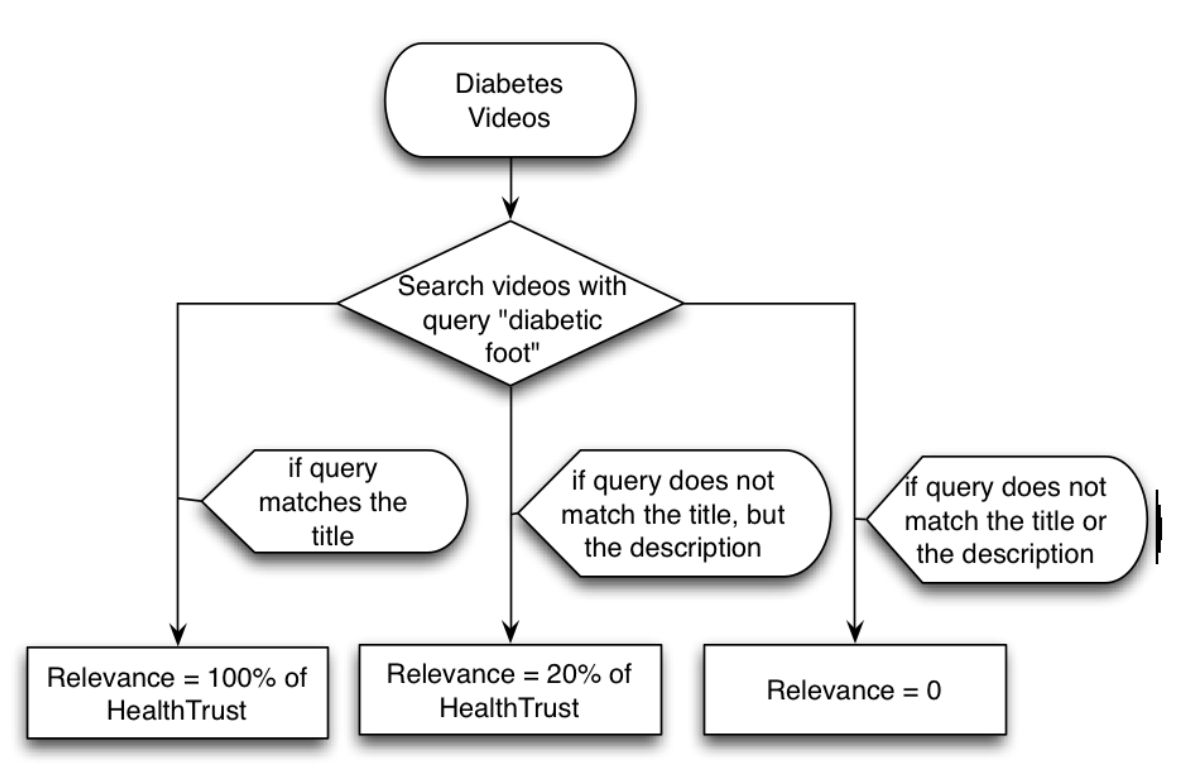
Figure 6. Relevance calculation for HealthTrust-based